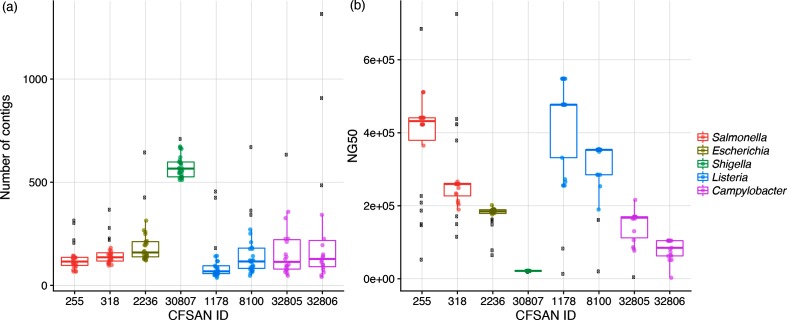
Box and whisker plots summarizing two different assembly statistics: (a) number of contigs and (b) NG50, a measure of contig length. The box defines the median value, as well as the lower and upper quartiles (25 and 75 %). The whiskers extend to the most extreme data point that is no more than 2.5 times the interquartile range from the median. Outliers are shown as black dots. The colours are genus specific.